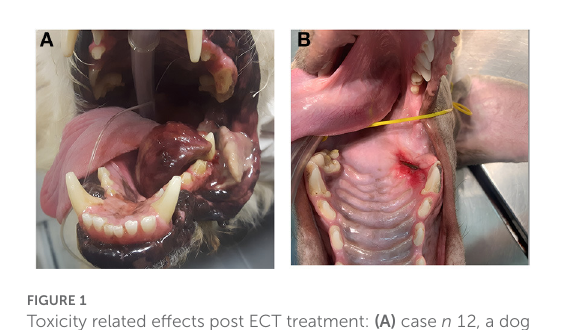
FIGURE1 Toxicity related effects post ECT treatment: (A) case n 12, a dog with a large oral malignant melanoma after the first electroporation during the first follow-up, showing severe tumour necrosis on the lateral aspect of the left mandible (grade 5 toxicity); (B) case n 17 showing a grade 2 toxicity and local